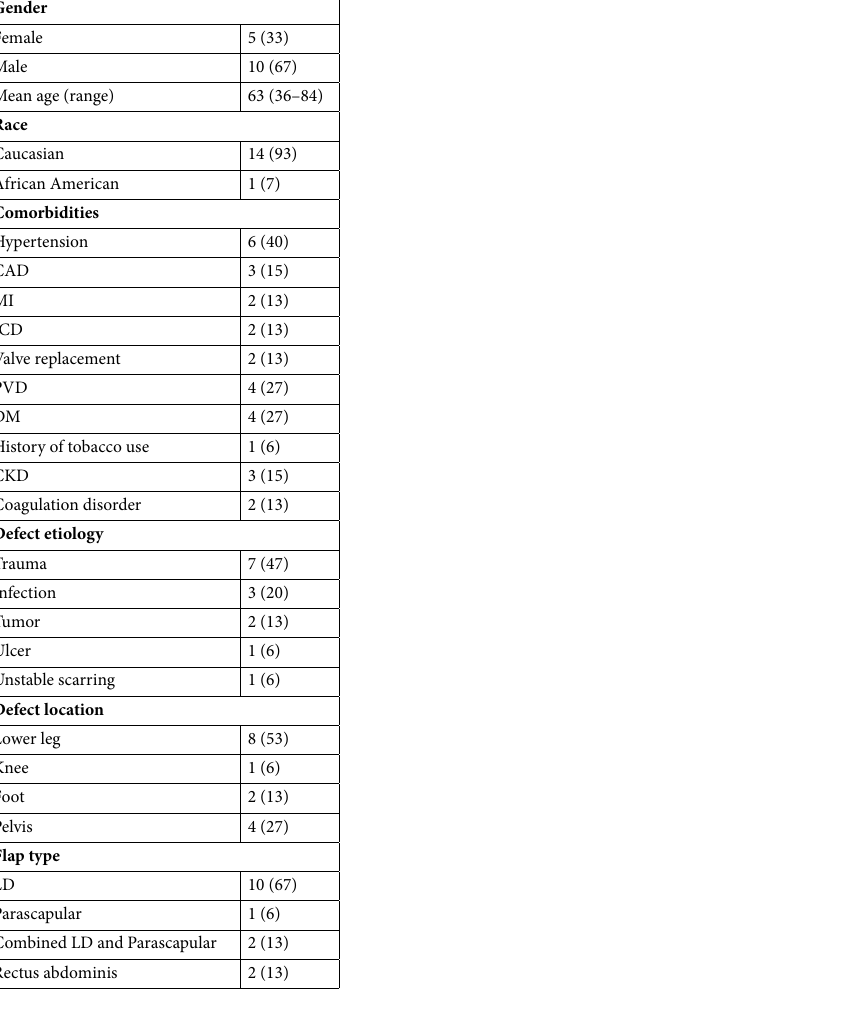
Table 1. Demographic characteristics, comorbidities and flap types of the patients. CAD coronary artery disease, ICD implanted cardioverter defibrillator, MI myocardial infarction, PVD peripheral vascular disease,